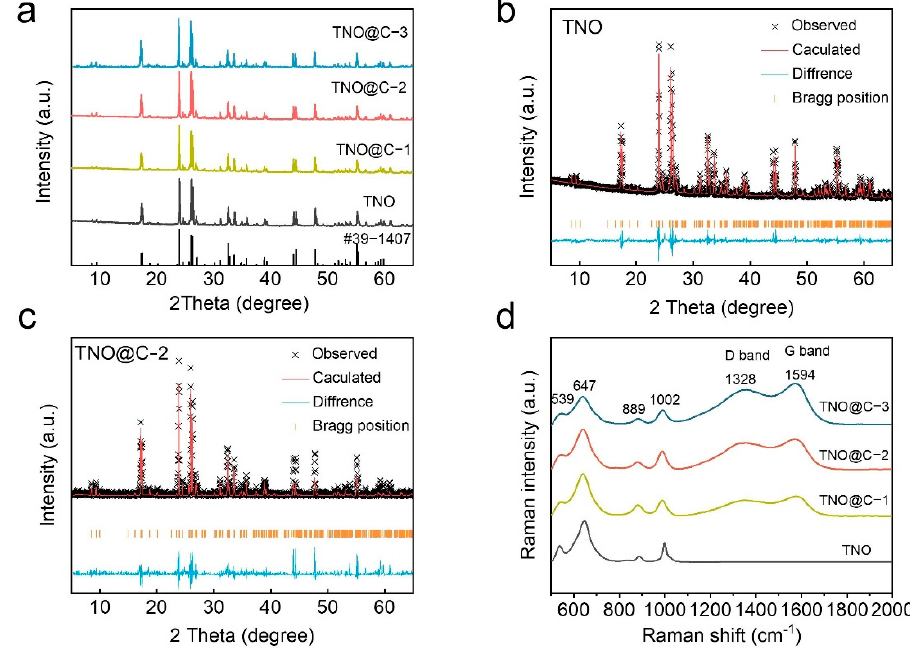
Figure 2. ( a ) XRD patterns of TNO and TNO@C; Refinement patterns of XRD for ( b ) TNO and ( c ) TNO@C-2 material; ( d ) Raman spectrum of TNO and TNO@C.